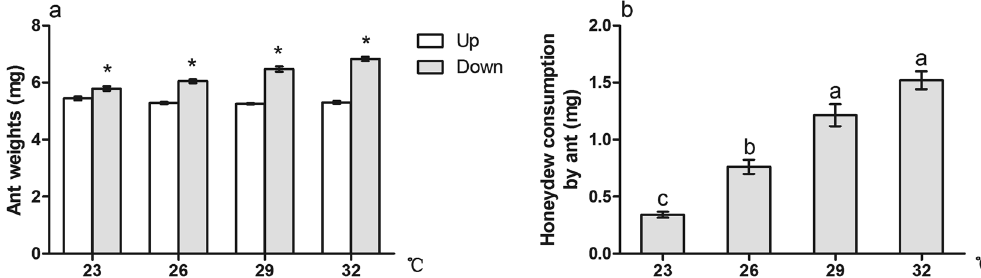
Figure 6. Effect of temperature warming on the honeydew consumption by ant. ( a ) Difference of ant weights between traveling down and traveling up; ( b ) Temperature. Results are expressed as the means ± SE. Asterisk ( * ) on bars indicate significant differences in the ant weights between travel up and travel down ( P < 0.05). Bars sharing the same letters indicate no significant differences between the treatments ( P >